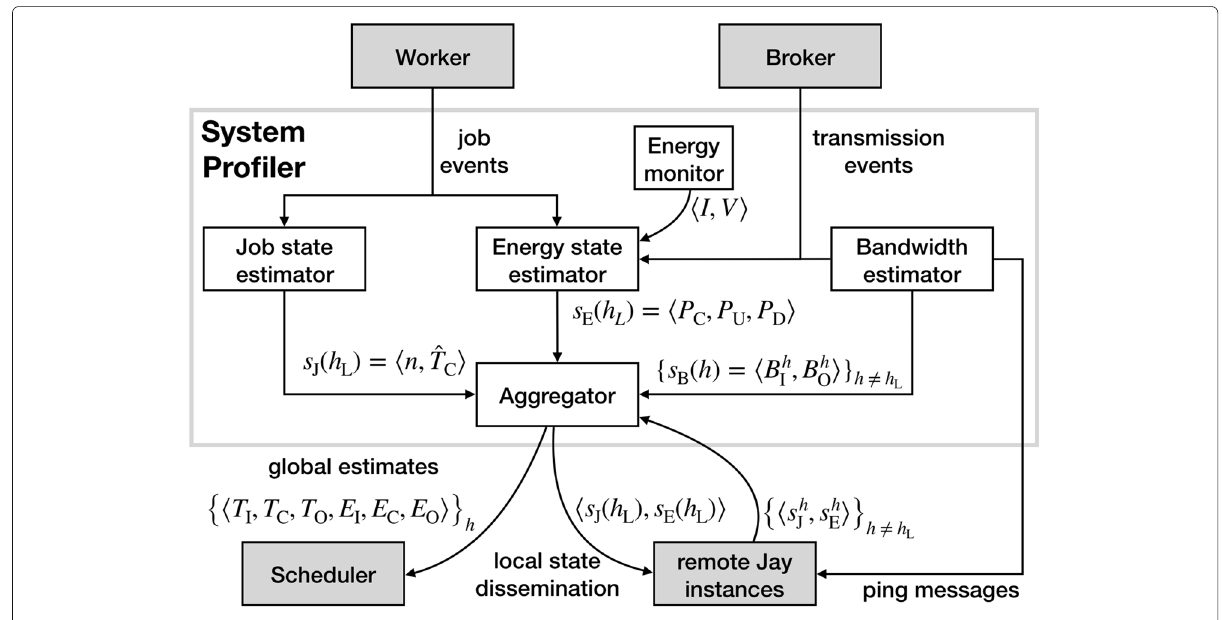
Fig. 5 State estimation by the system profiler